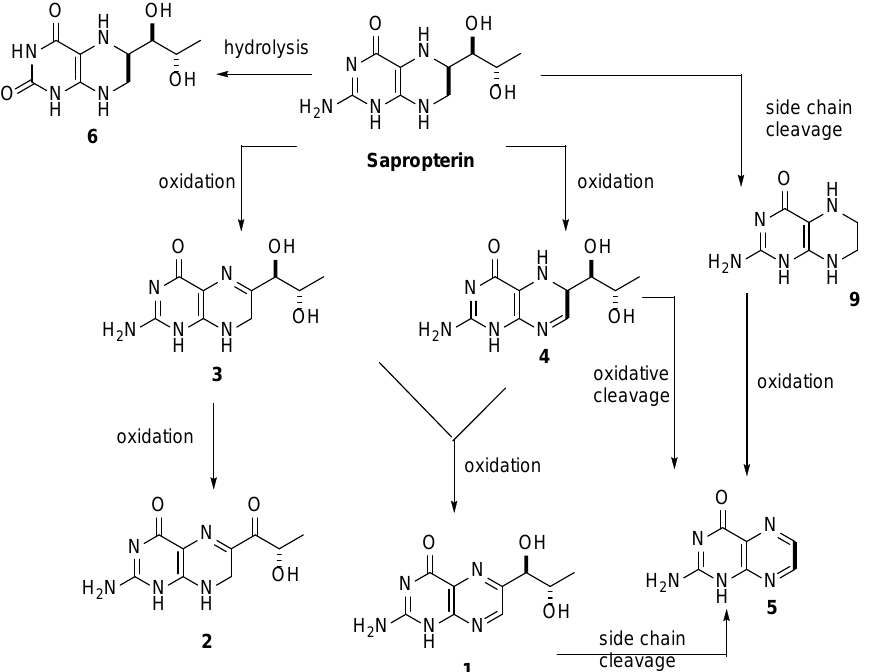
Figure 4. Proposed conversion scheme for the sapropterin degradation products detected in the HPLC-UV analysis.